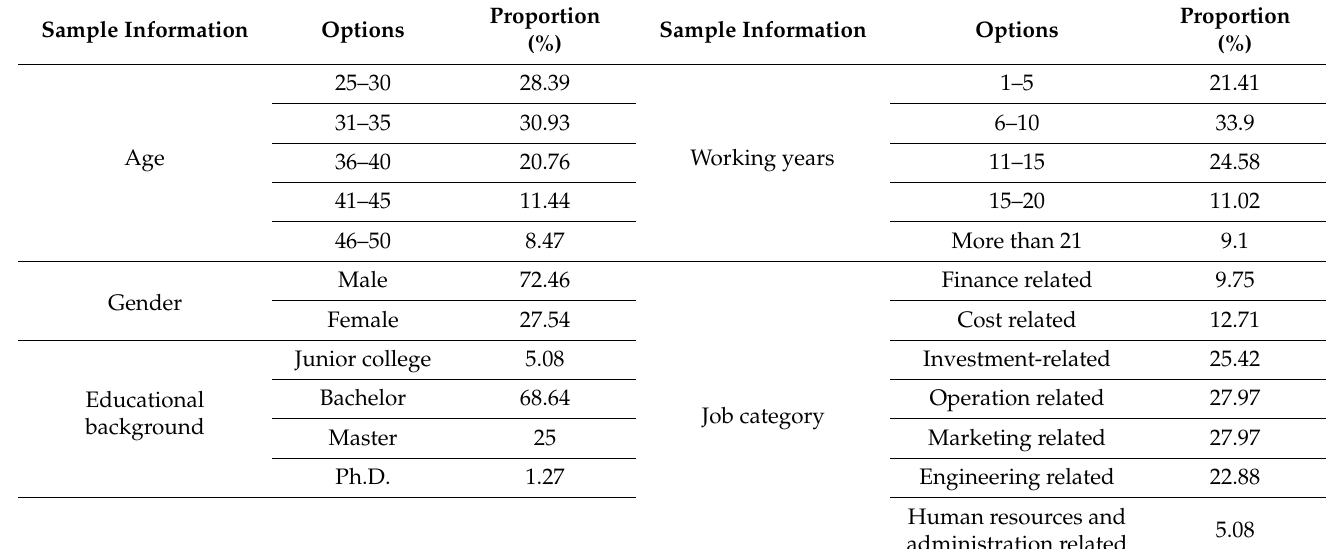
Table 3. The basic information of the